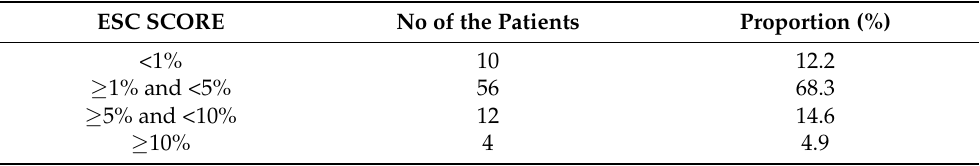
Table 2. Distribution of patients’ cardiovascular risk (SCORE) [14].